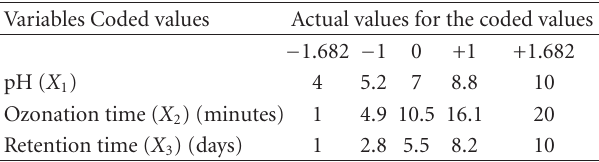
Table 2: Level of factors and their values used for the experiment. Variables Coded